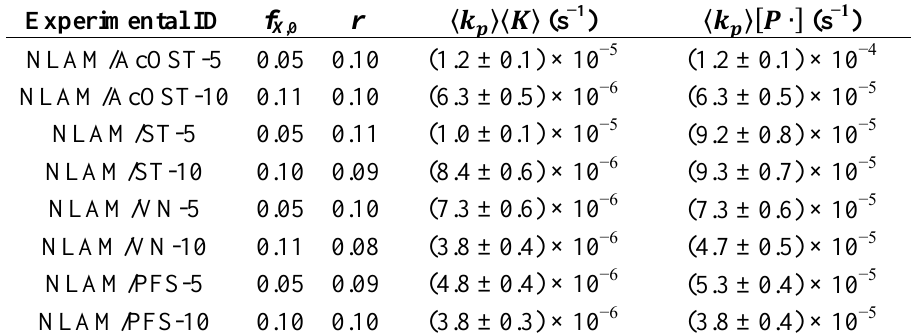
Table 2. The summary of copolymerization kinetic data of 5-methacryloyloxy-2,6-norboranecarbolactone (NLAM)/X (X = controlling co-monomer) controlled by BlocBuilder ® at 90 °C in 35 wt% 1,4 dioxane solution. Experimental